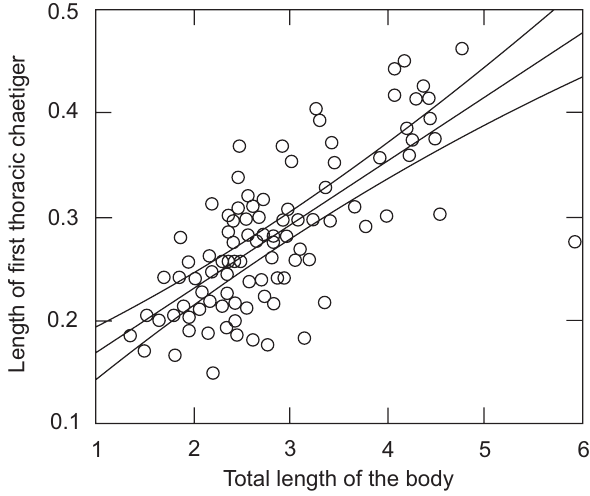
Figure 10. Linear regression of total length of the body and length of first thoracic chaetiger, calculated for the total sampled speci- mens of P. caudata .